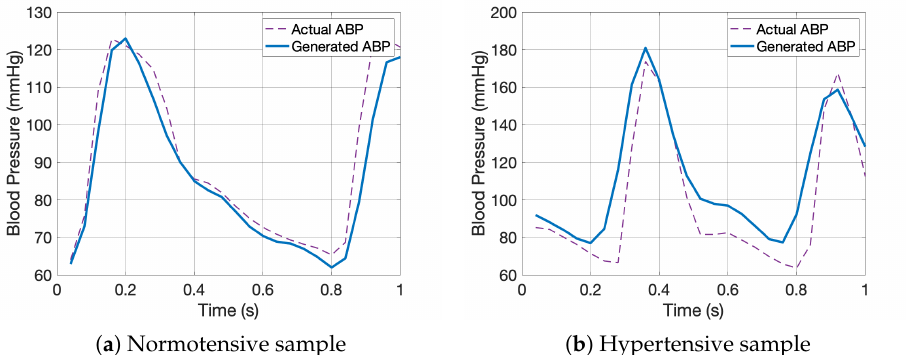
Figure 5. Generated ABP Waveforms using neural network